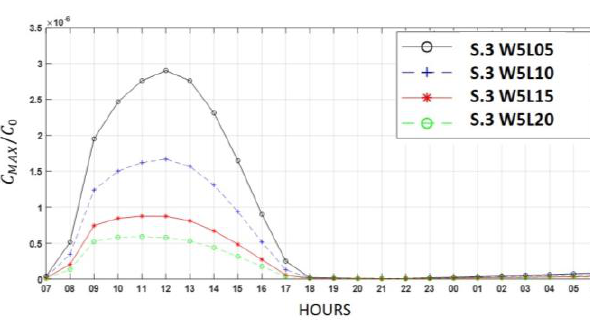
Fig. 10. Daily variation of the nondimensional maximum CO concentration C MAX /C 0 inside the street 3, for the different simulated courtyard